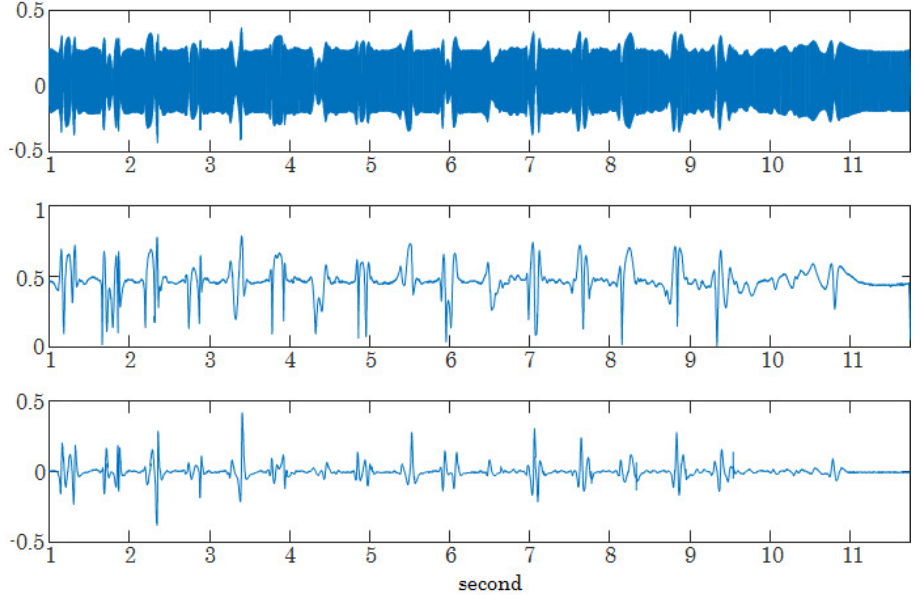
Figure 4. An example of signals received from the sensor device when cashew nuts were eaten. Top : The bandpass filtered signal. Middle : Demodulated signal. Bottom : Audio signal obtained by the low-pass